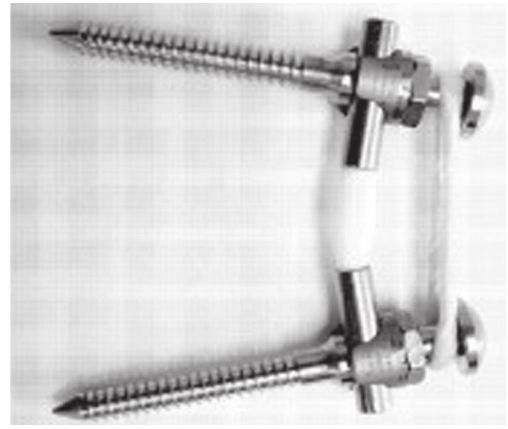
Figure 9: The Fulcrum-Assisted Soft Stabilization system (FASS).